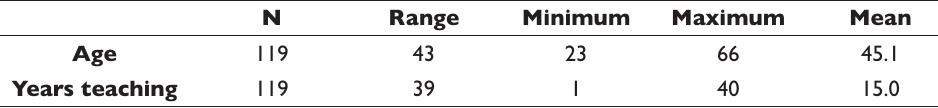
N Range Minimum